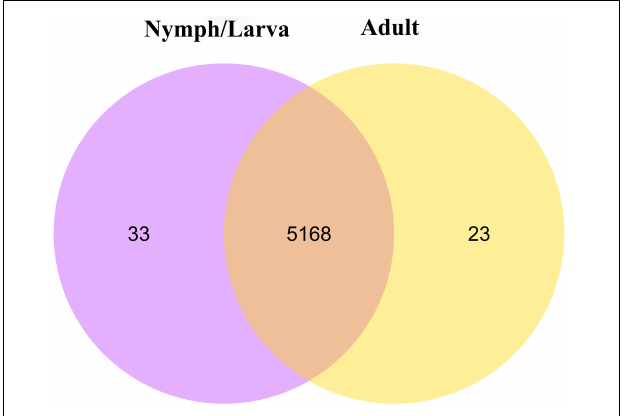
FIGURE 5 | A Venn diagram of differentially expressed genes (the criteria for differential gene screening are |log2(FoldChange)| > 0&qvalue < 0.05).